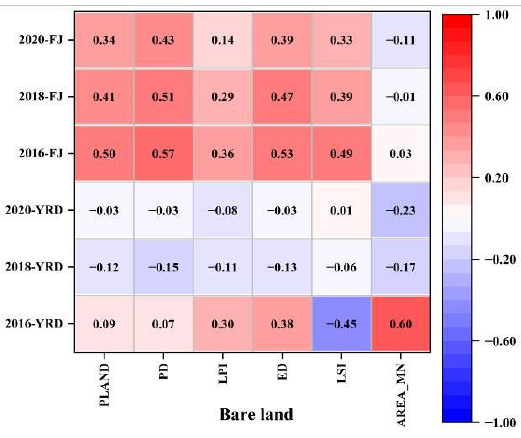
Figure 6. Correlation coefficients between six landscape patterns and PM 2.5.